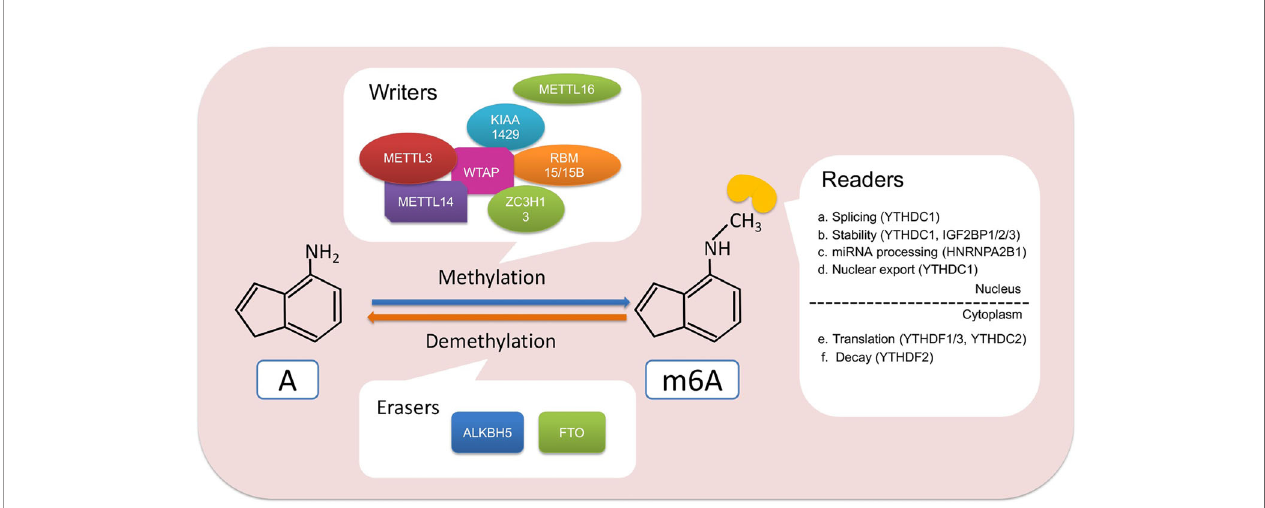
FIGURE 1 | Regulators and functions involved in m6A modi fi cation. m6A writer, such as METTL3 and METTL14, binds to RNA to methylate adenine. Then, the m6A readers including YTHDC1/2, YTHDF1/2/3, IGF2BP1/2/3, and HNRNPA2B1 recognize the m6A site and participate in the process of RNA splicing, stability, nuclear transport, translation, degradation, or miRNA processing. In addition, m6A modi fi cations can also be erased by FTO and ALKBH5, thereby affecting the fate of RNA. A,